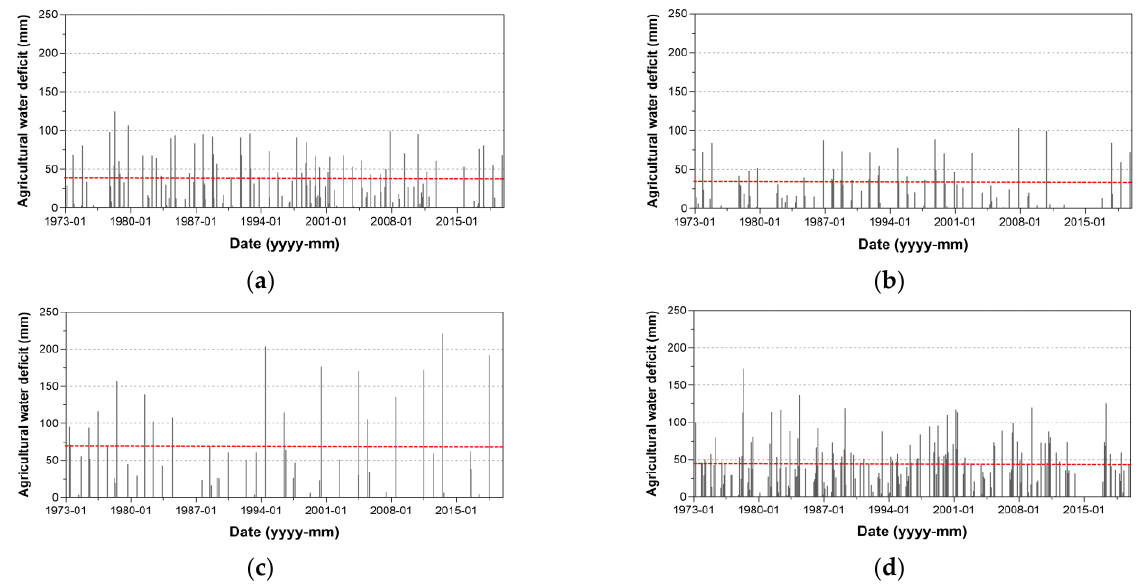
Figure 10. Agricultural water deficit estimated for each crop considered in this study from 1973 to 2019. ( a ) Garlic; ( b ) Spring Onion; ( c ) Peanut; ( d ) Barley.